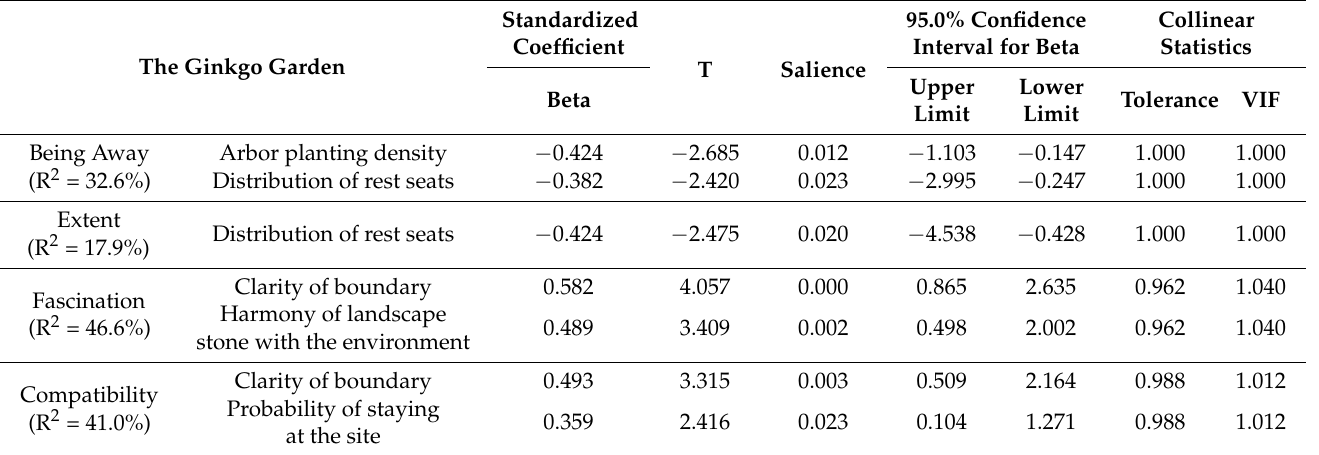
Table 4. Correlation between Spatial Landscape Element Characteristics and Restorative Perception in the ginkgo garden.